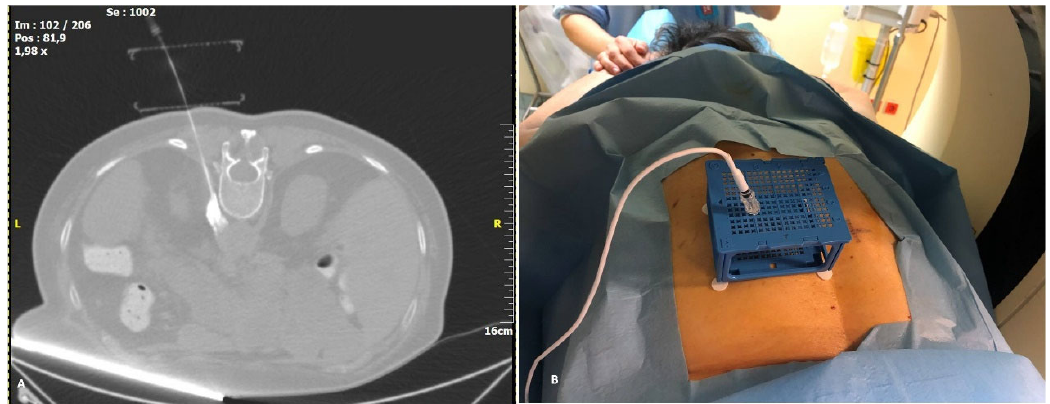
Figure 4. Final image prior to treatment: ( A ): Corrected (MPR) CT image of the cube with the needle in place, showing the whole needle trajectory. At the tip of the needle, there is hyperdense contrast pooling, verifying the correct needle position. ( B ): Actual image of the needle and electrode in place inside the cube.